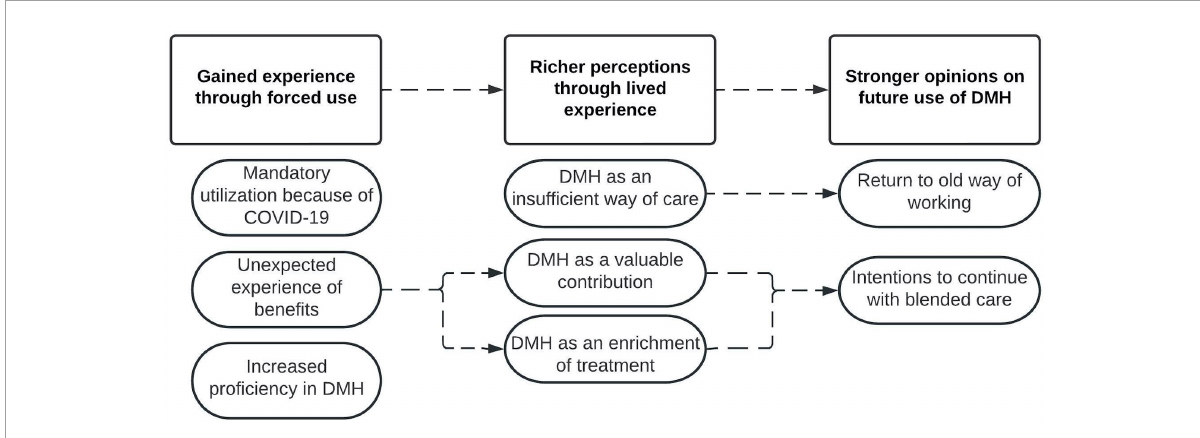
FIGURE6 Model of derived (sub)themes of practitioners’ perceptions and experiences regarding DMH. Squares present themes, ovals present subthemes, and dotted lines present proposed relationships between